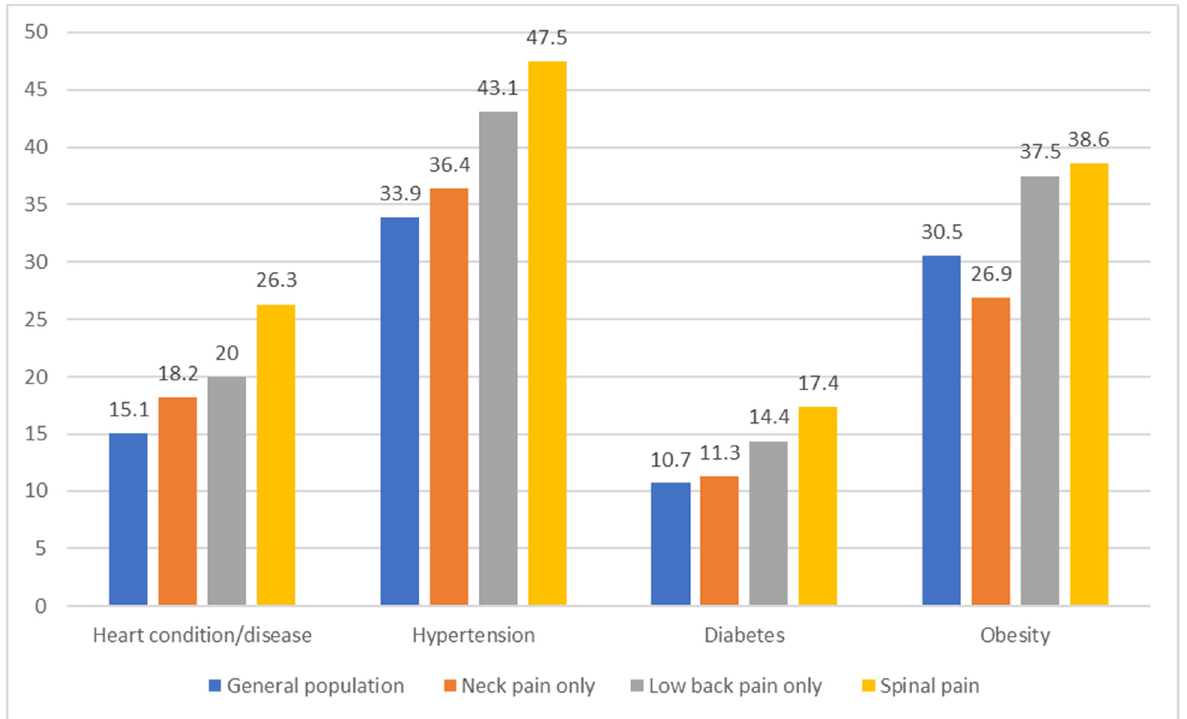
Figure 1. Prevalence of neck pain only, low back pain only and spinal pain in the US adult population, by chronic health conditions, 2016–2018.